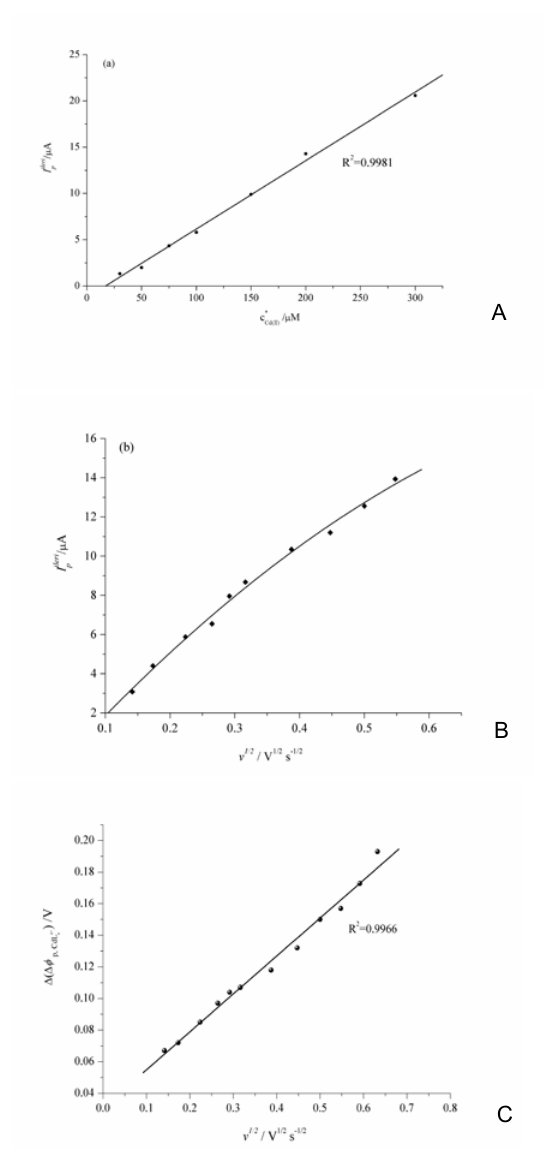
The changes of forward peak current of the MAPPT-assisted Cd 2+ transfer across the water/1,2-DCE interface as a function of (a) the bulk concentrations of Cd 2+ ion; (b) the square root of the scan rate; (c) The difference between the obtained Galvani ion transfer forward and back scan peak potentials as a function of scan rate at the experimental conditions.